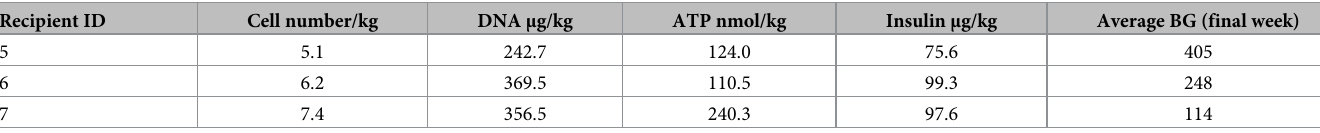
Table 5. Transplant cellular